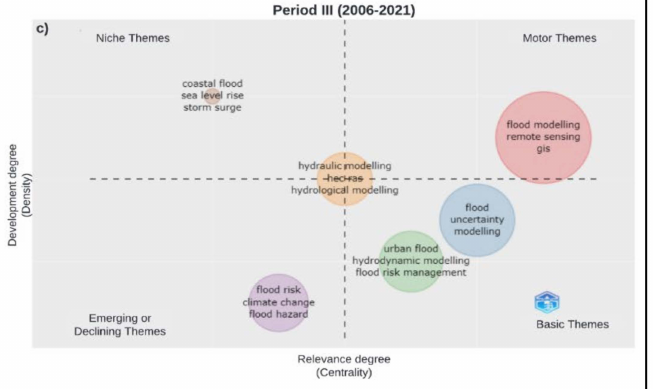
Figure 8. The conceptual structure of author’s keywords during the three periods analysed.